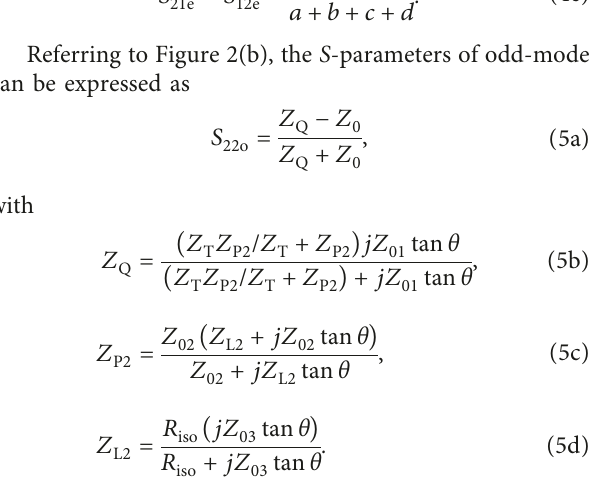
0 of the proposed NGD